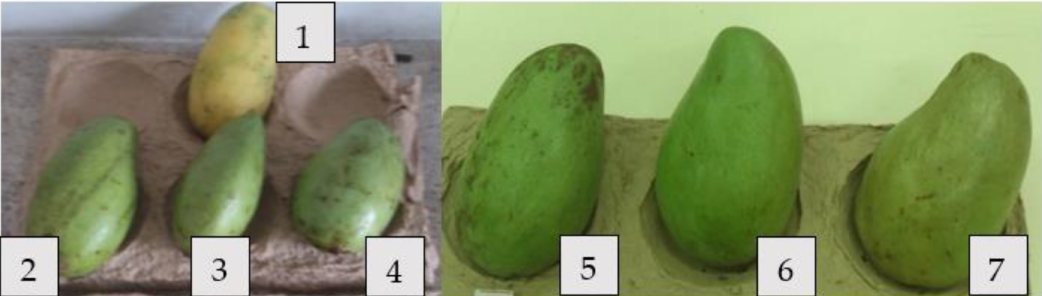
Figure 5. The color of mangoes at 9th day storage: ( 1 ) the control sample (uncoated); ( 2 ) 0.75% NaCS coating; ( 3 ) 1% NaCS coating; ( 4 ) 1.25% NaCS coating; ( 5 ) 1.5%P/NaCS coating; ( 6 ) 2% P/NaCS coating; and ( 7 ) 2.5% P/NaCS